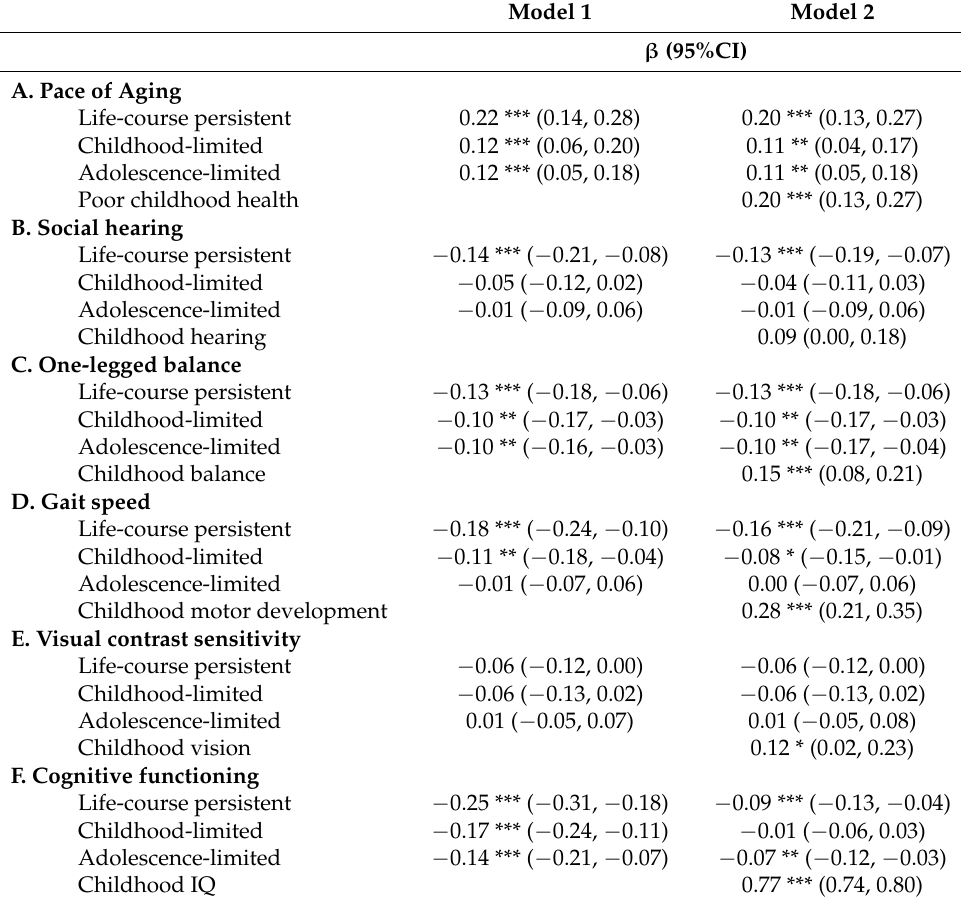
Table 2. Association between developmental trajectories of antisocial behavior and midlife aging outcomes. Model 1 presents the association adjusted for participants’ sex. Model 2 presents the model adjusted for participants’ sex and each of the corresponding baseline measures of childhood health in order to test whether there has been health decline from early life. Standardized regression coefficients and 95% confidence intervals (CI’s) are presented for all